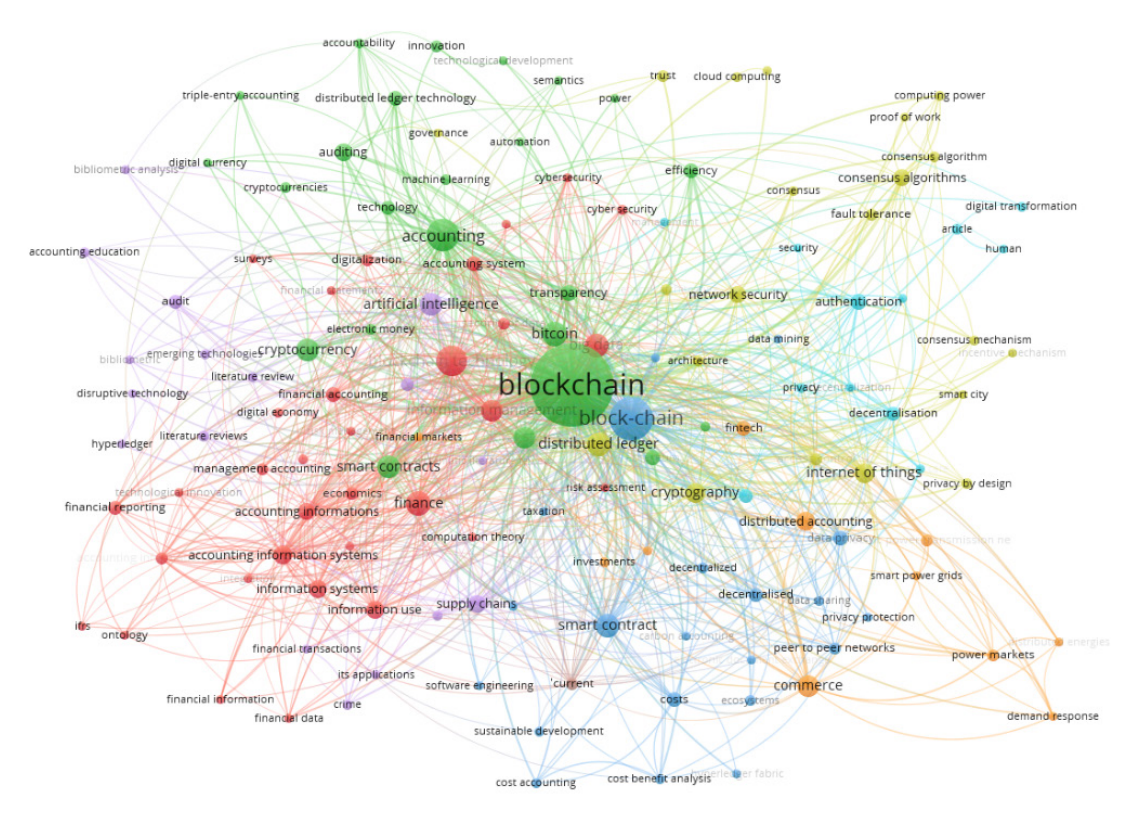
Figure 2. Identification of the interrelationship of “blockchain” AND “accounting” with other